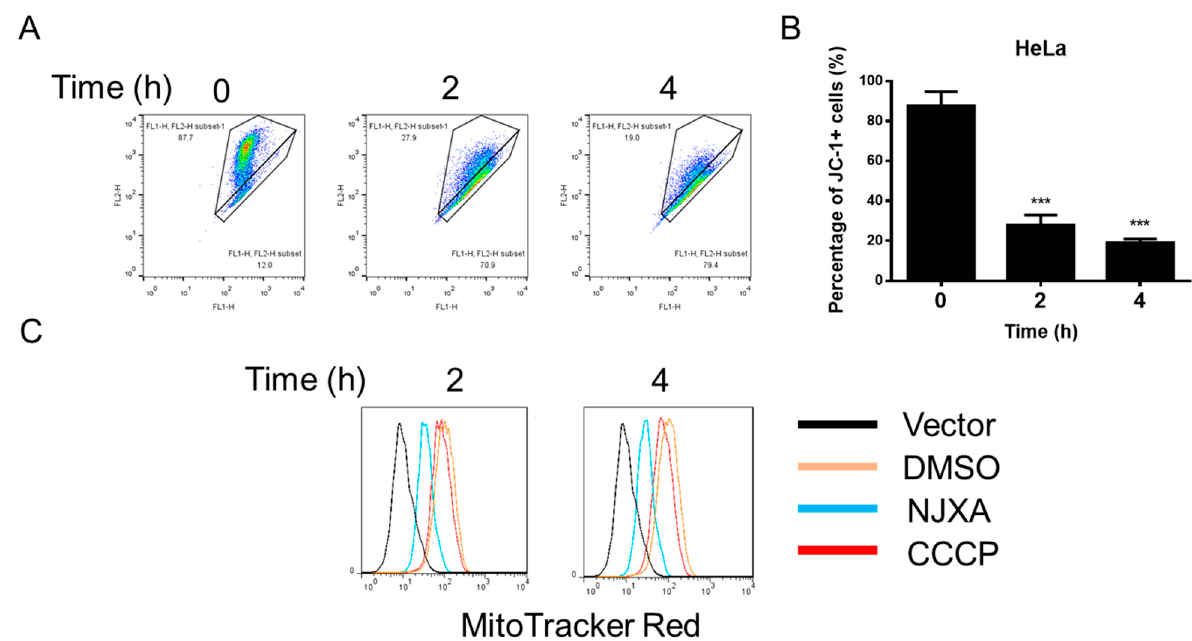
Figure 2. NJXA degrades mitochondria in HeLa cells. ( A ) HeLa cells treated with NJXA (20 µ M) for 0, 2, and 4 h were collected for mitochondrial membrane potential detection. ( B ) Quantification of the proportion of JC-1 positive cells of ( A ). *** p < 0.001. ( C ) HeLa cells were treated with NJXA (20 µ M) or CCCP (20 µ M) for 0, 2, and 4 h; labeled with MitoTracker Red (100 nM); and analyzed by immunofluorescence and flow cytometry.